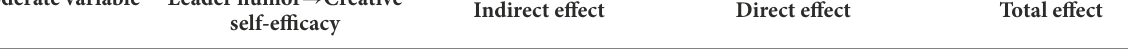
TABLE 5 Results of moderated mediation